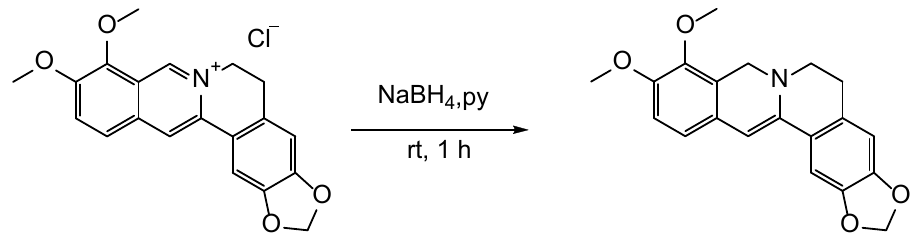
Figure 2. Synthesis of dihydroberberine. py, pyridine; rt, room temperature.